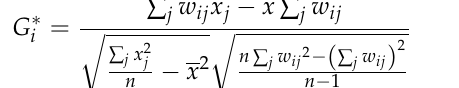
Figure 3. Visualization of the transmission chain of different stages. ( a ) Transmission chain in Stage I; ( b ) Transmission chain in Stage Ⅱ ; ( c ) Transmission chain in Stage Ⅲ .